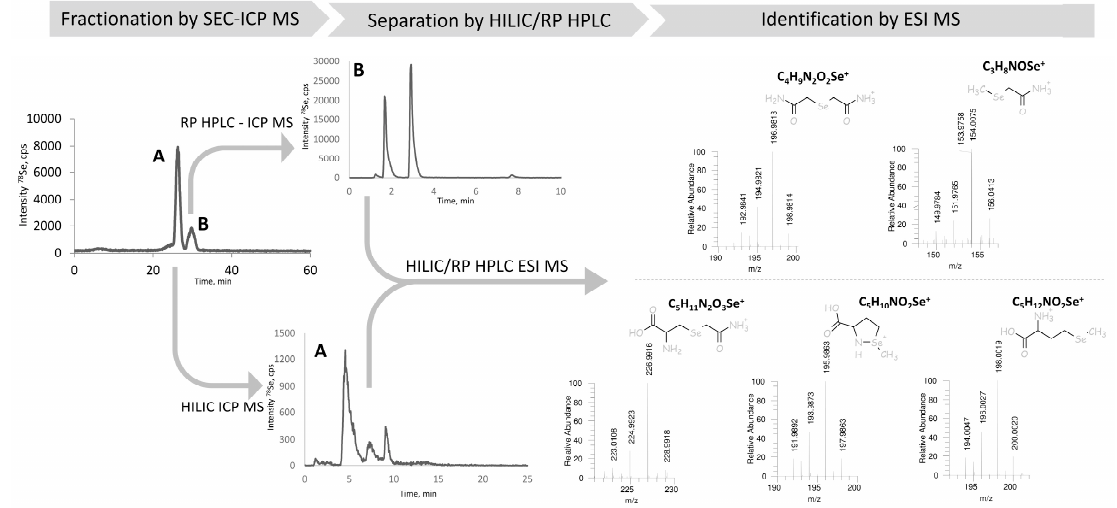
Figure 3. The scheme of the chromatographic purification selenium species in the proteolytic digest prior to HPLC-ESI MS identification including: initial fractionation of the proteolytic digest by SEC-ICP MS, separation of the resulting fractions by HILIC (fraction A ), and RP (C18) HPLC (fraction B ) with dual ICP MS/ESI MS detection, leading to the identification of selenium species. For fraction A (peaks 1, 3, and 5 in Figure 2a) a positive result was obtained by hydrophilic ion interaction chromatography (HILIC). The three peaks identified correspond to CAM-SeCys ( m / z 226.9916), cyclized SeMet species ( m / z 195.9864) characteristic for terminal SeMet [34] and SeMet